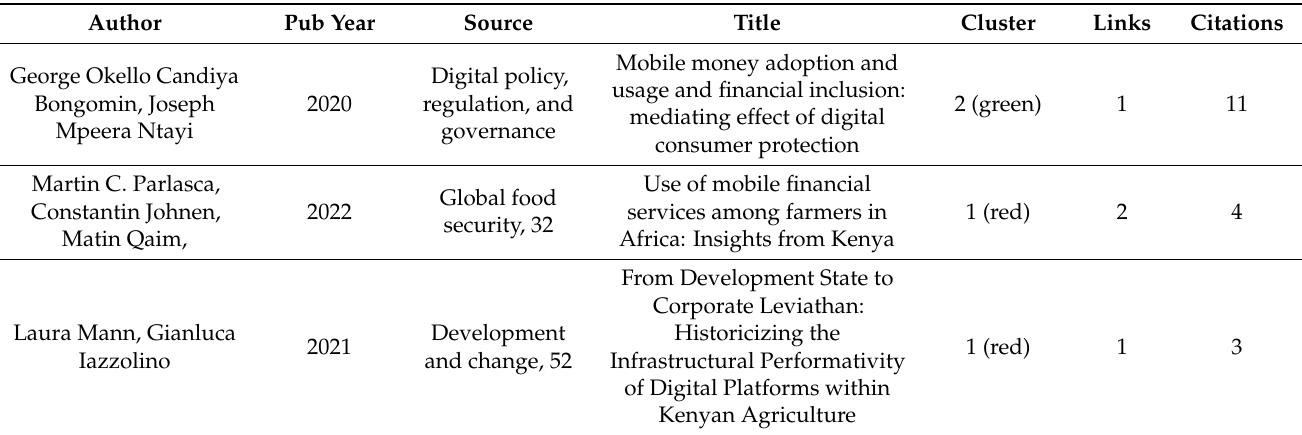
Table 6. Distribution of citations, clusters, and documents by